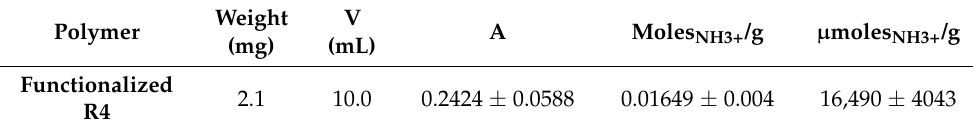
Table 3. Content of NH 3+ of R4 by the method of Gaur and Gupta.